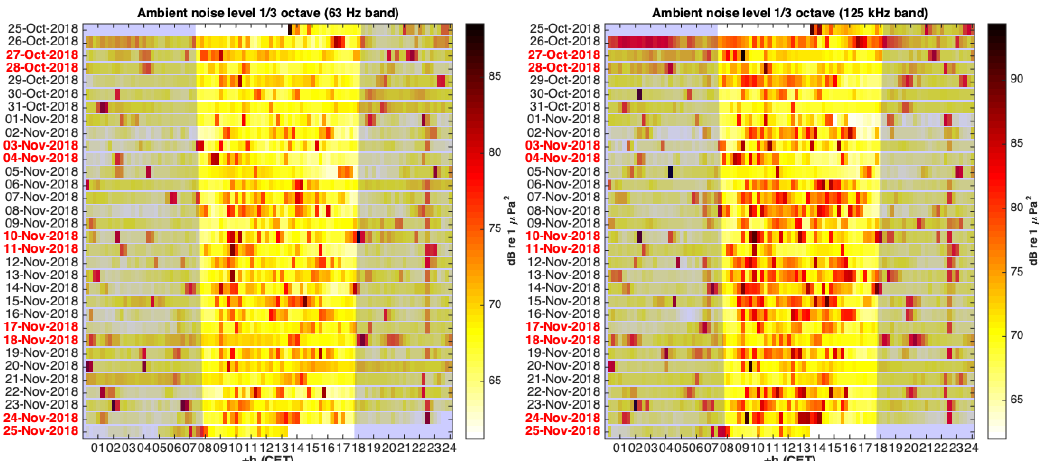
Figure 8. Heat map representation of 1/3 octave noise indicators in El Gorguel (Cartagena). Each pixel gives an indication of the noise level in a 15-min period. The left panel shows the SPL 1/3 at 63 Hz whereas the right panel shows the SPL 1/3 at 125 Hz. Sunrise/sunset times were calculated for longitude, latitude, and all deployment dates using a generic astronomy calculator. These sunrise/sunset times have been indicated using light shadow areas.